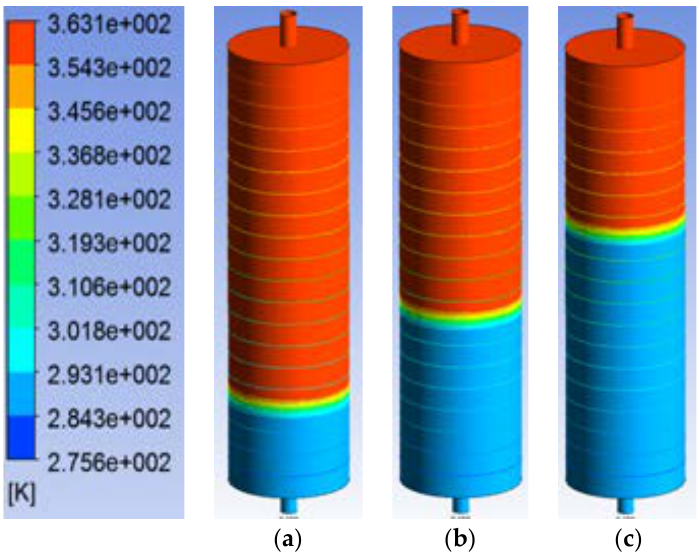
Figure 13. TES-1 at 90 °C, 2.0 cm/s: ( a ) 400 s; ( b ) 800 s; ( c ) 1200 s.